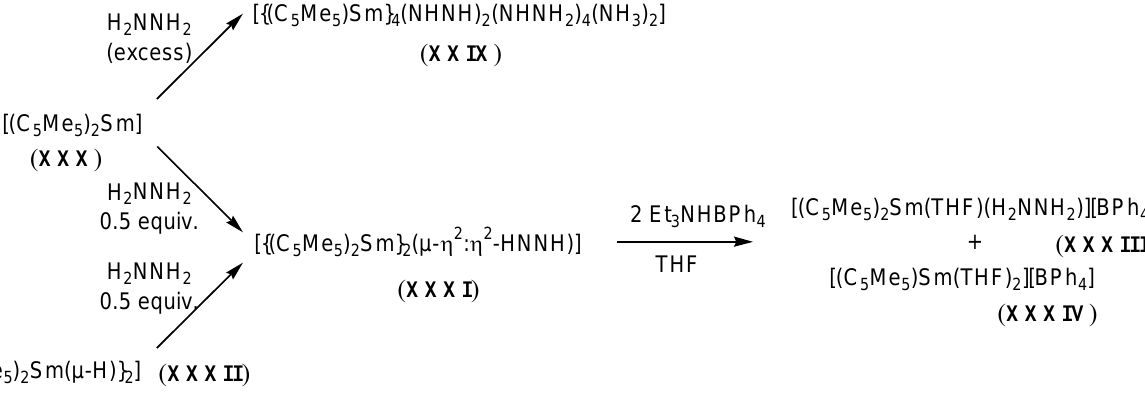
Me ) Sm(N(H)Ph)(THF)], ( XXXVI ) [35]. Figure 5 5 2